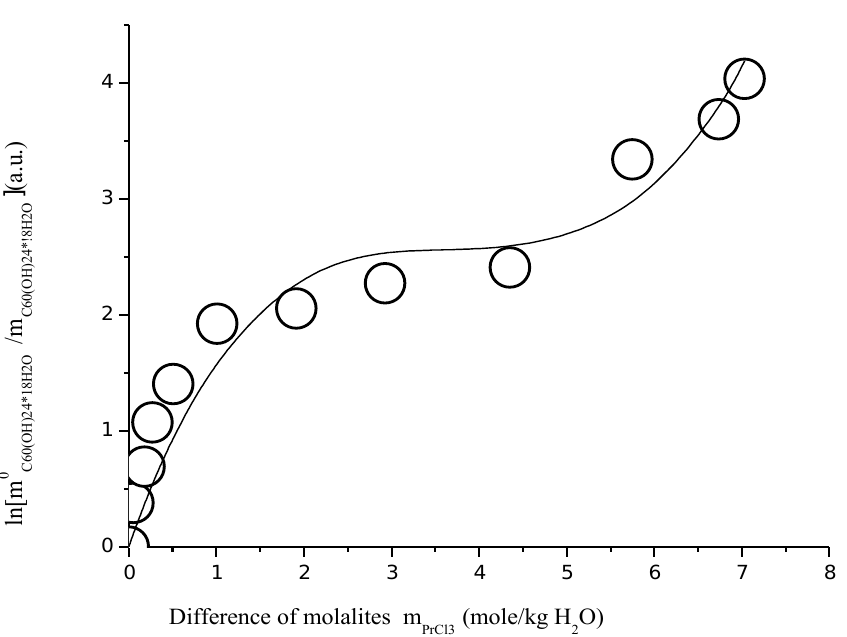
Figure 19. Branch of crystallization C 60 (OH) 24 *18H 2 O in the diagram of solubility in ternary system C 60 (OH) 24 —TbCl 3 —H 2 O at 25 ◦ C (convex-conxave σ − id line—calculation according to modified three-parameter Sechenov equation SEM(CS)-3—Equation